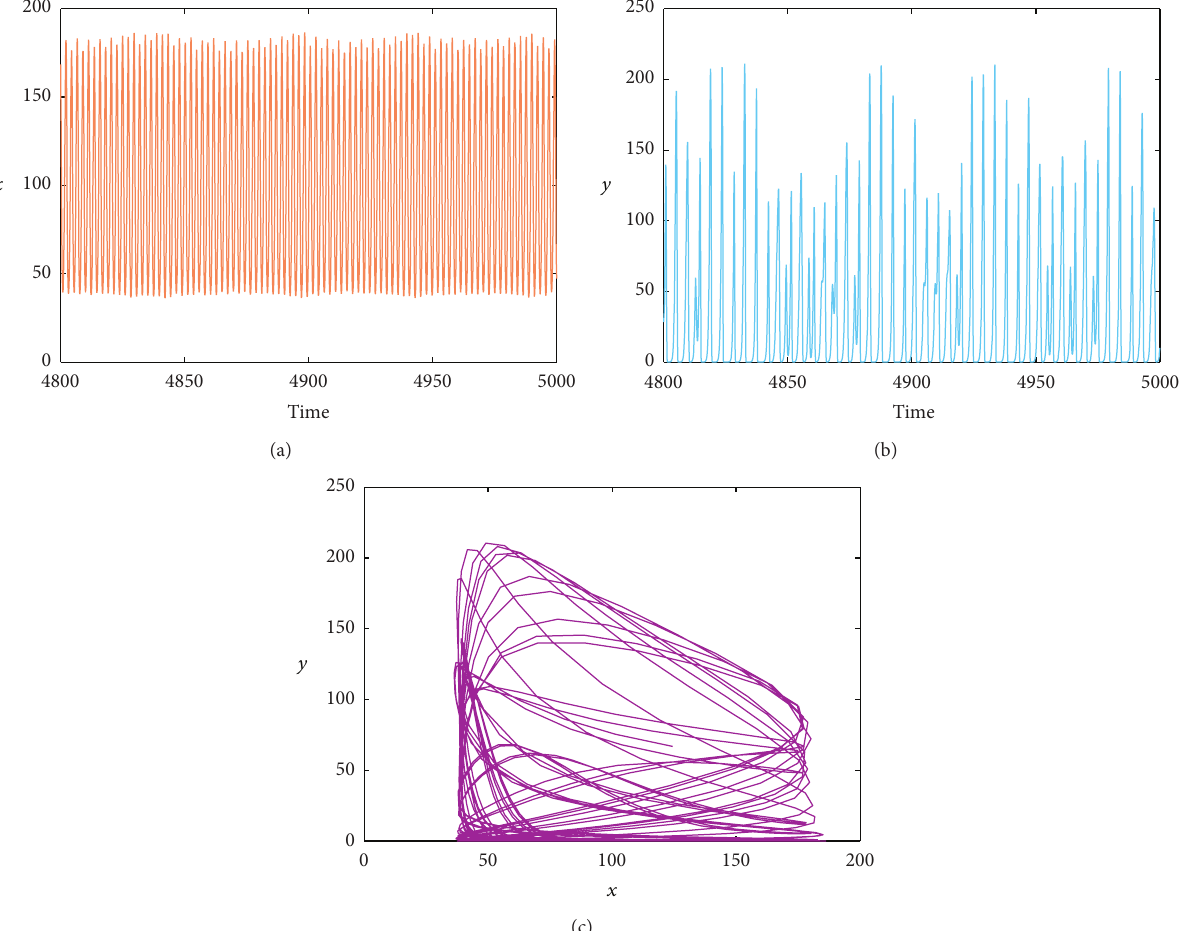
Figure 6: Time evolution (a)-(b) and phase-plane diagram (c) of the system (3) for 𝜏 1 = 0.56 and 𝜏 2 = 0.535 . Here, the system (3) exhibits chaotic behavior. Other parameters are as in previous